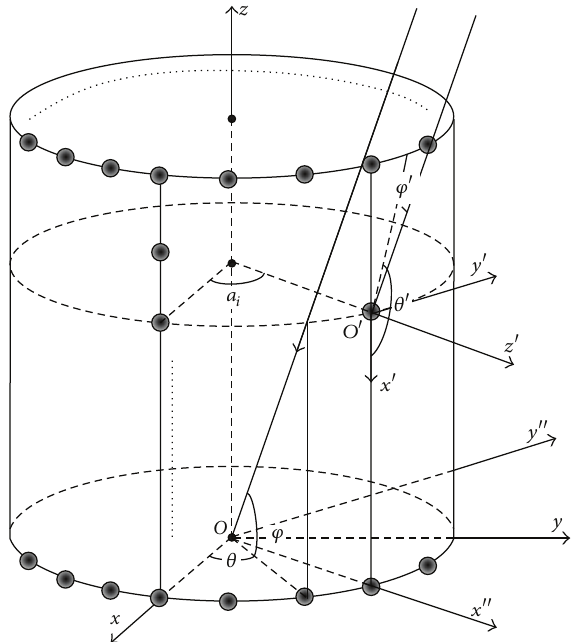
Figure 1: Geometry configuration and array coordinate system of cylindrical